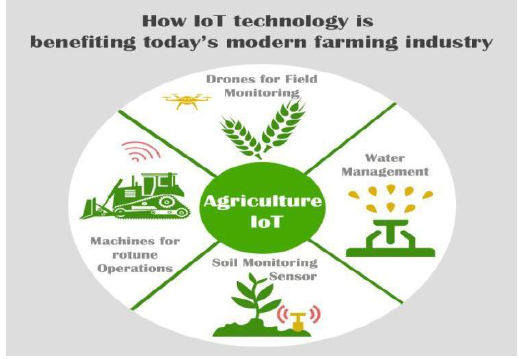
Fig. 1. Use of IOT in agriculture